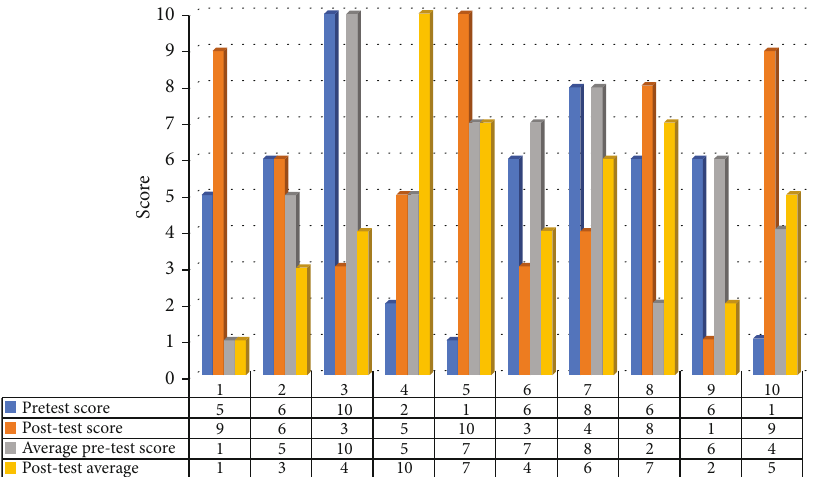
Figure 2: Score measured before and after